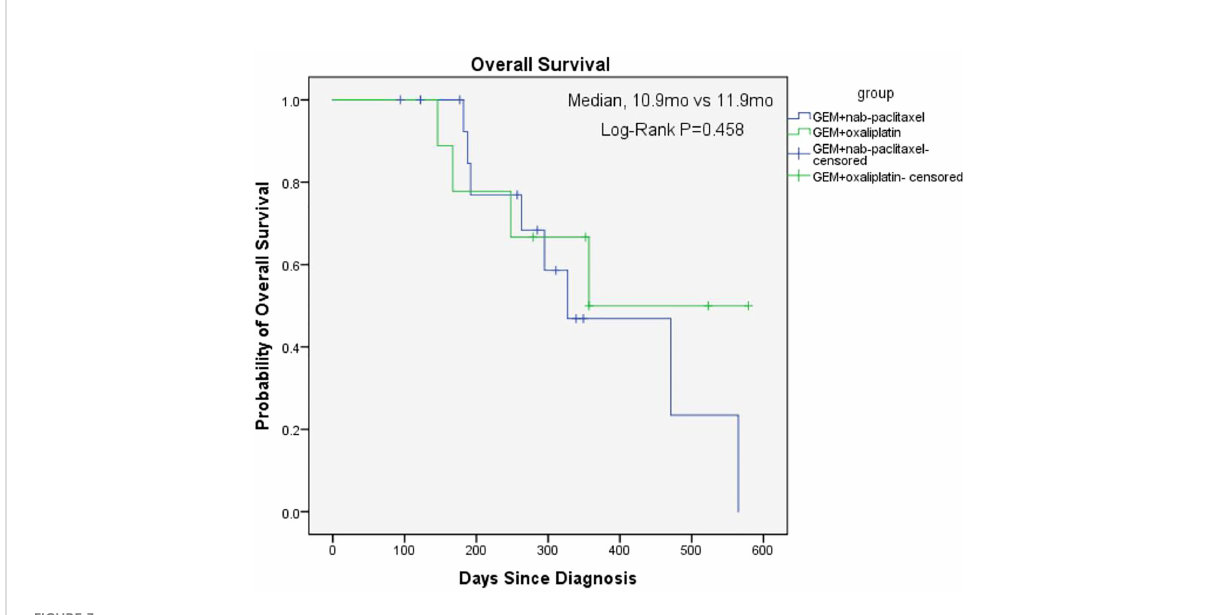
FIGURE 3 Kaplan-Meier Estimates of Overall Survival between two